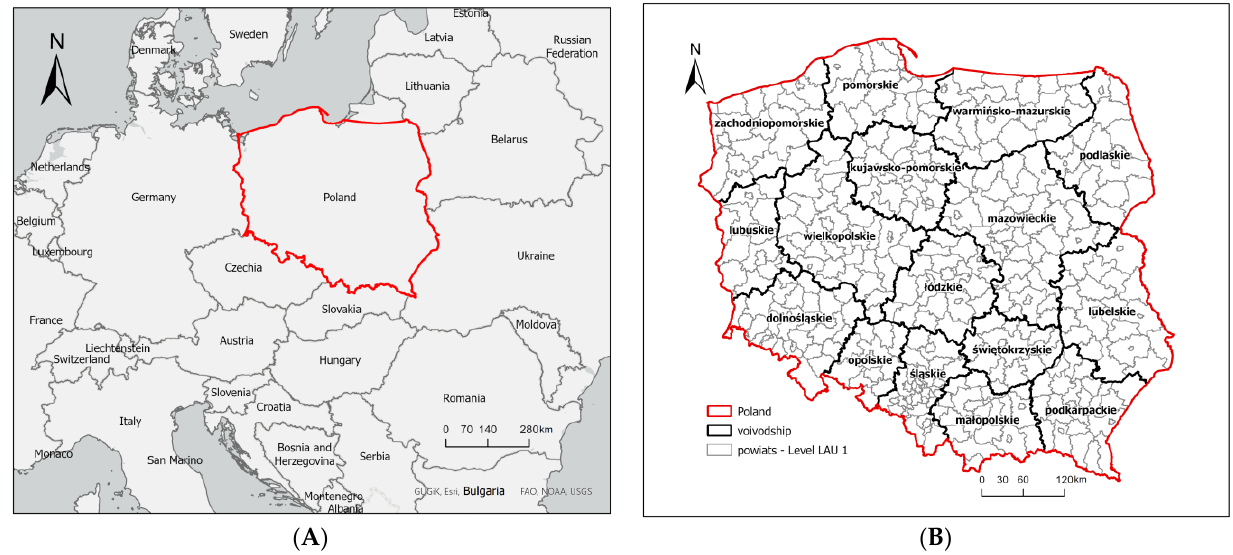
Figure 2. Location of the study area. ( A ) — Location of Poland on a map of Europe. ( B ) — Local Administrative Units in Poland. Source: own elaboration.